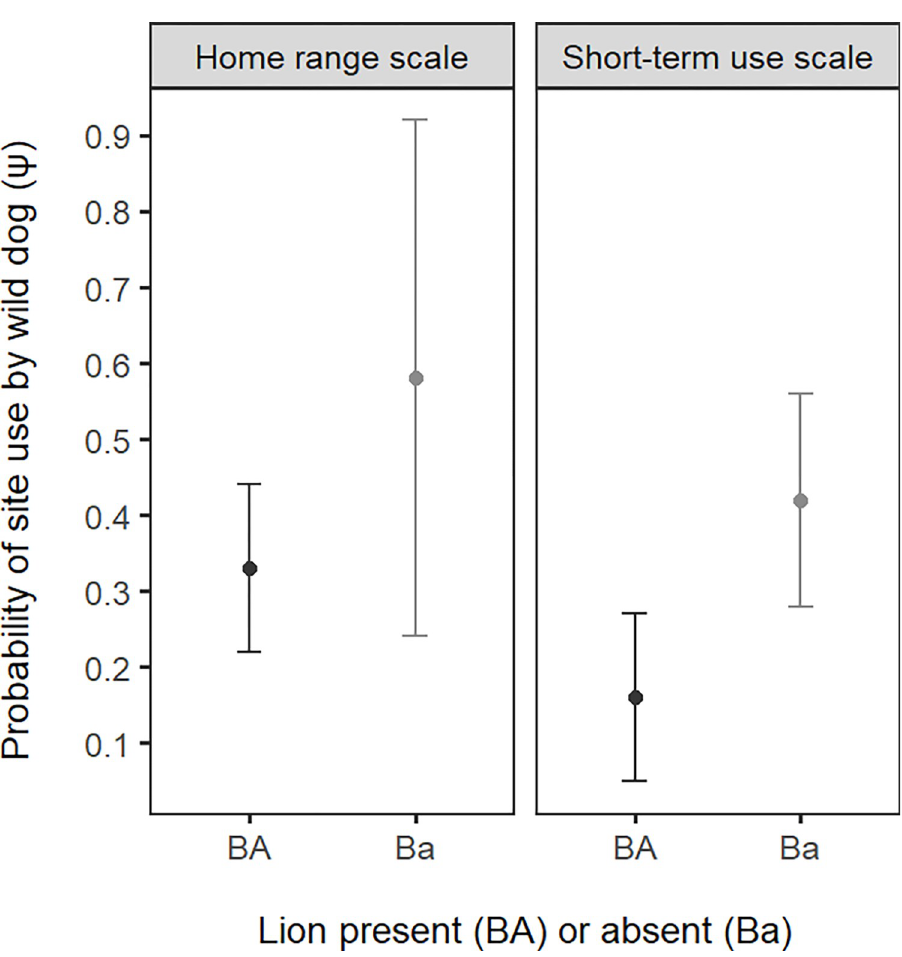
Fig 2. Mean probability of wild dog site use (with associated standard error) given the presence (BA) or absence (Ba) of lion, from the top-ranked model, at the two spatial scales investigated in Ruaha-Rungwa.